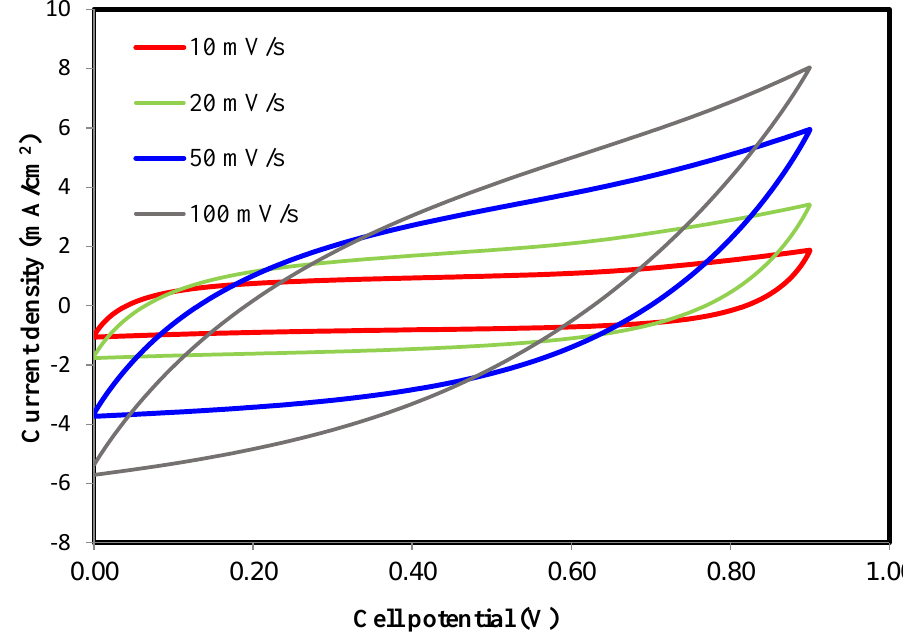
Figure 5. CV curve of the fabricated EDLC using PMNG-3 system. Table 4. Calculated C s of the EDLC from CV curves.